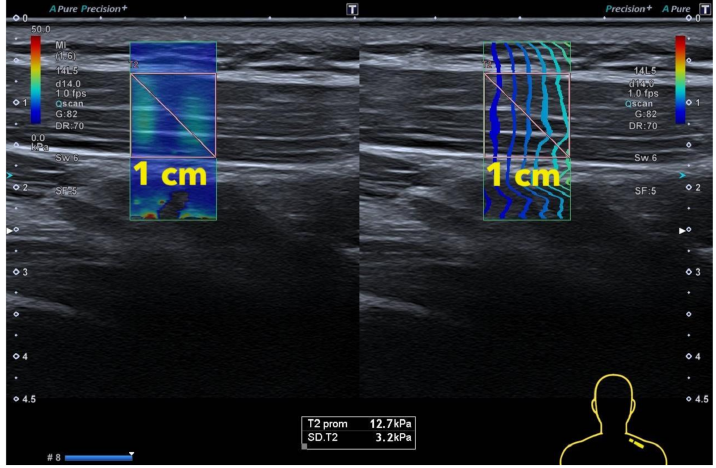
Figure 2. Shear Wave Elastography: Image